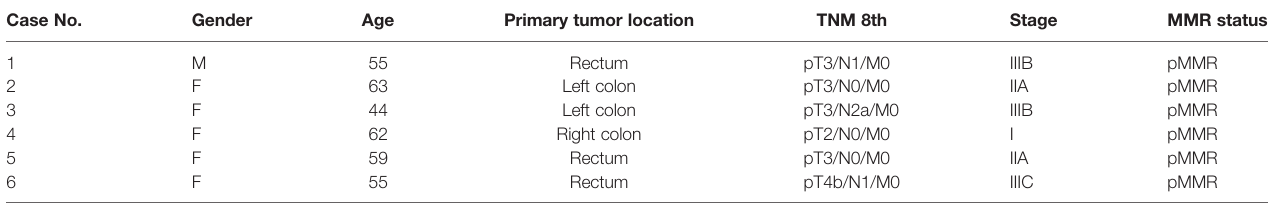
TABLE 1 | Patients and tumor characteristics of the sequencing set. Case